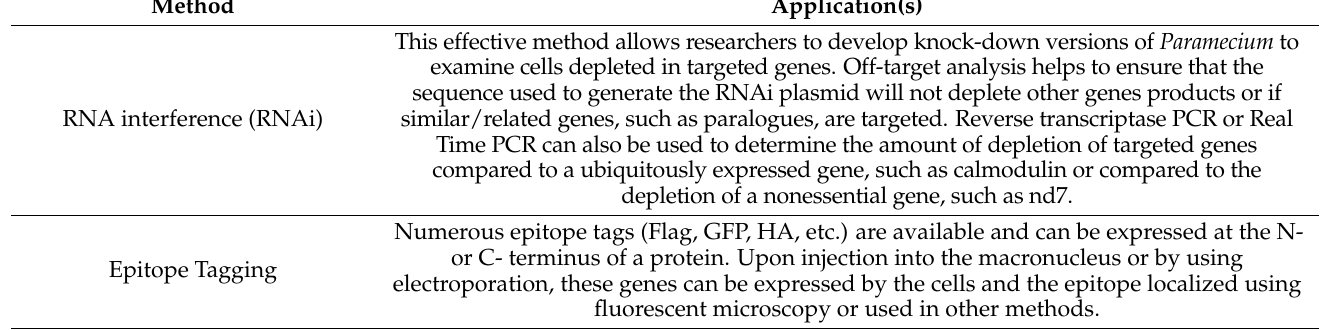
Table 2. Research Methods Used to Study Cilia Genes in Paramecium